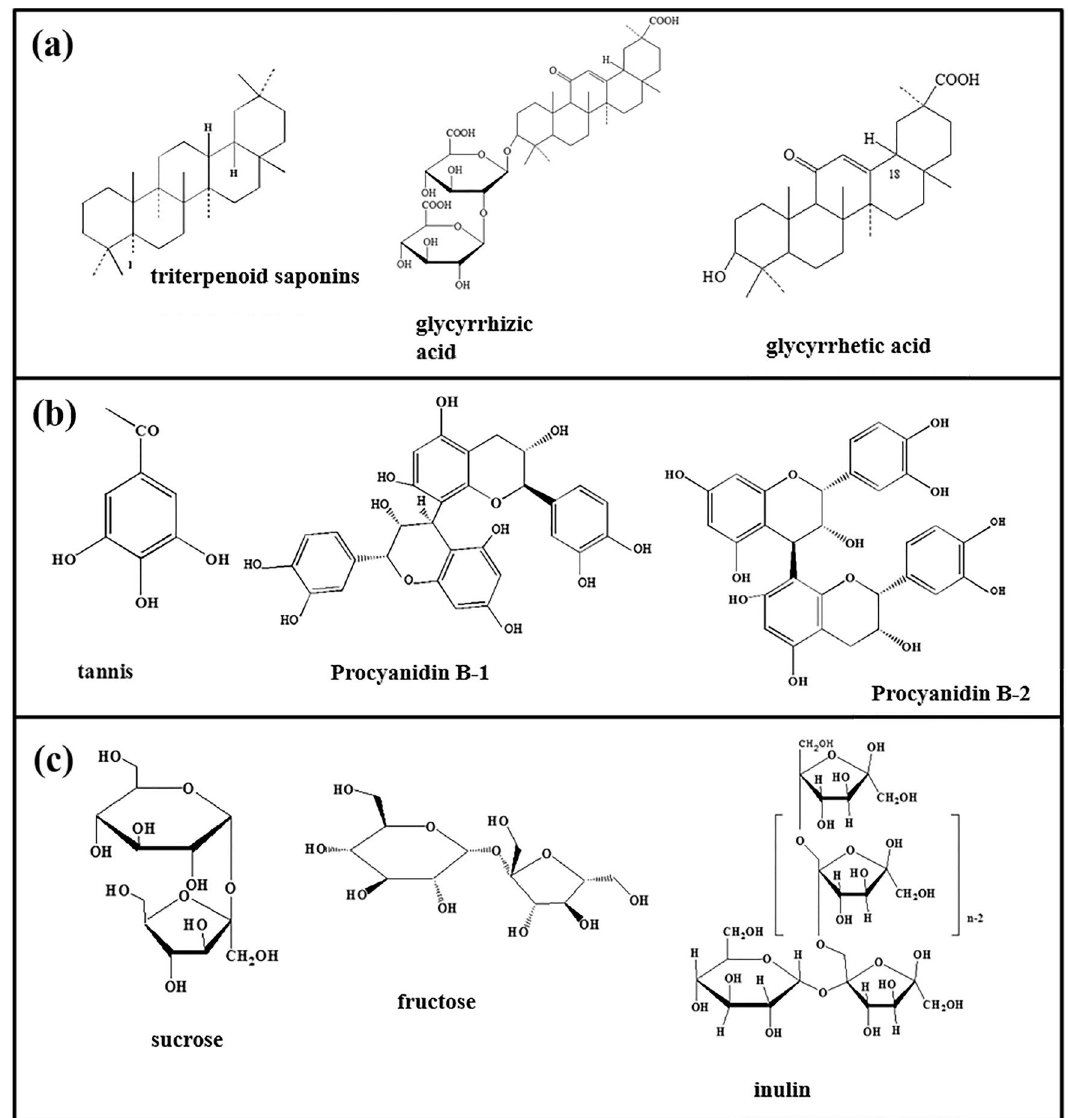
Figure 10. Molecular structures of the main components of ( a ) GUE, ( b ) PDE and ( c ) TOE,